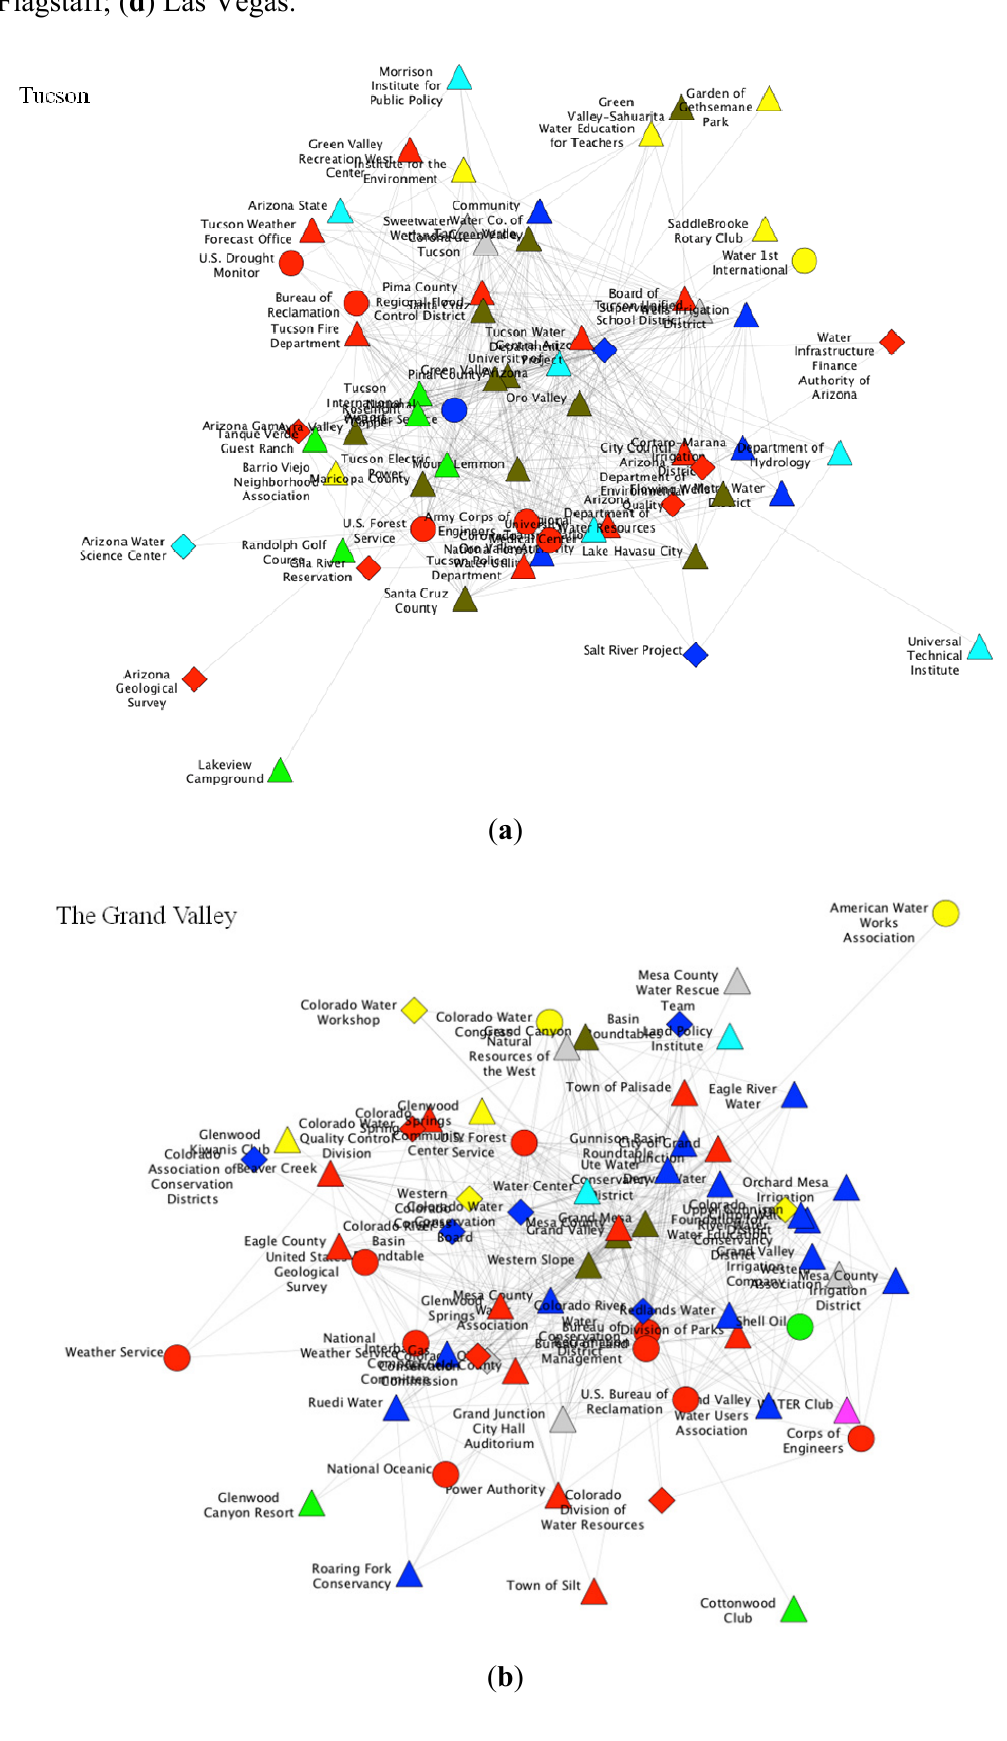
Figure 4. Networks generated from Step 2 results. ( a ) Tucson; ( b ) The Grand Valley; ( c ) Flagstaff; ( d ) Las